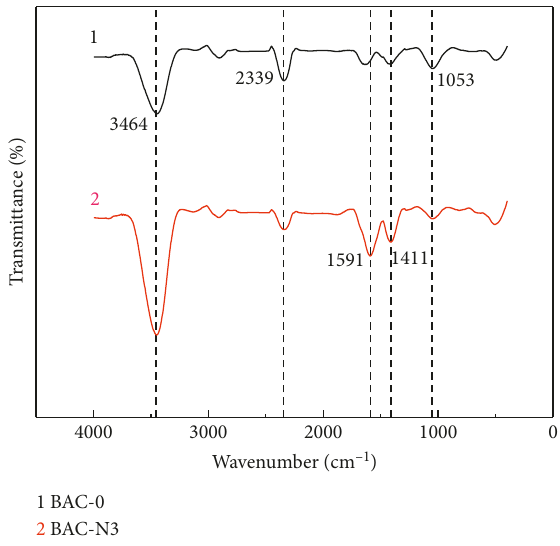
Figure 2: FIIR of BAC-0 (1) and BAC-N3 (2). Table 4: Content of oxygen functional groups on the surface of BACs.